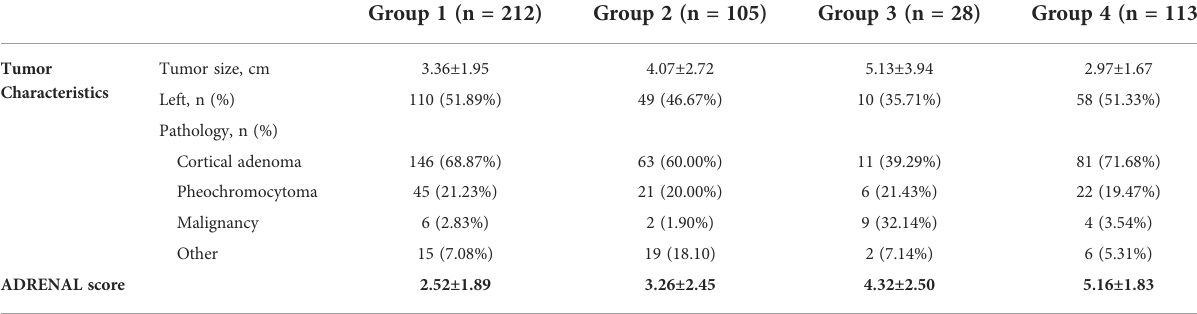
TABLE 3 Tumor characteristics.